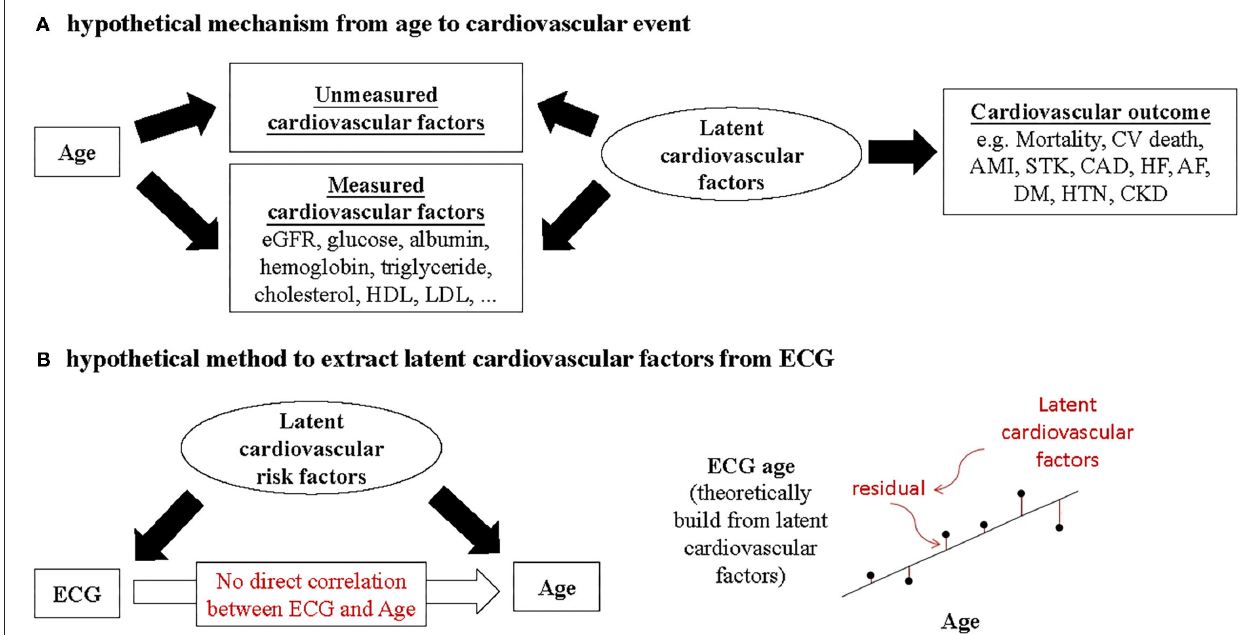
FIGURE 1 | (A) Chronological age is not direct correlation to cardiovascular outcome. Cardiovascular outcome is correlated with the influence period of unmeasured cardiovascular factors and measured cardiovascular factors. (B) Under the assumption of no direct correlation between ECG and chronological age, the DLM can theoretically use the latent cardiovascular factors to generate the ECG-age for predicting chronological age. The residuals between chronological age and ECG-age may imply the information of latent cardiovascular factors. The hypothesis of why ECG-age can more accurately predict the cardiovascular outcome than the chronological age. The ECG provide more information of latent cardiovascular